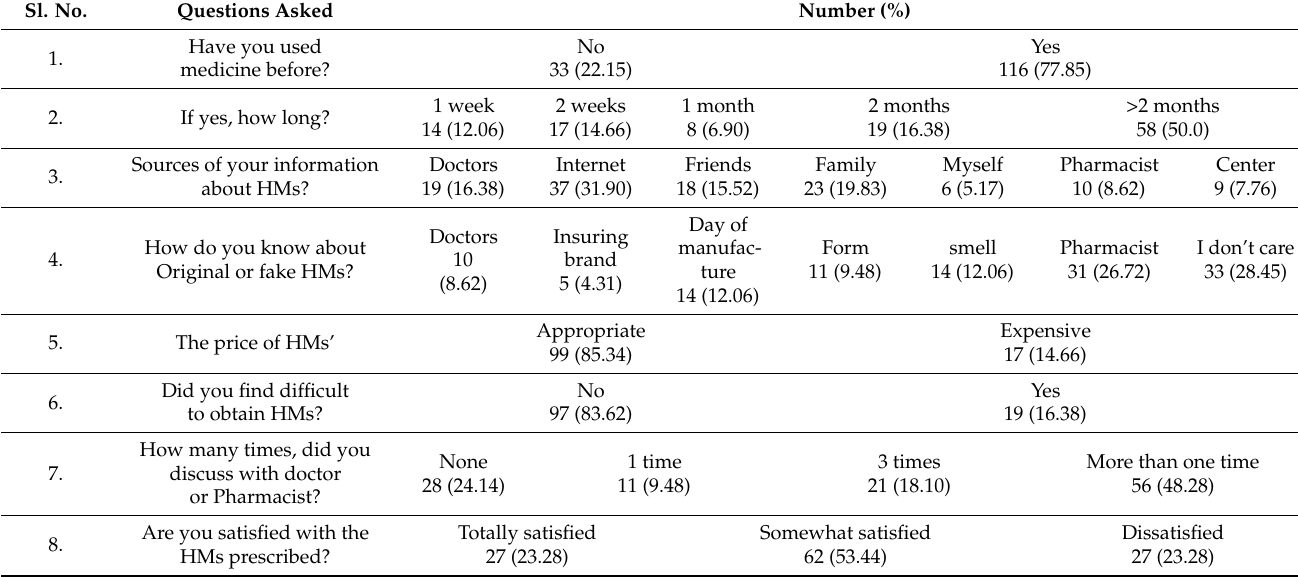
Table 3. Attitudes of respondents towards HMs and their information sources ( n = 149).